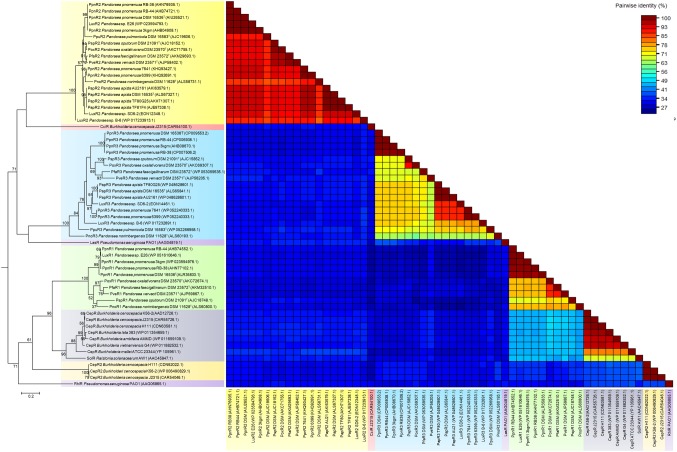
LuxR phylogenetic tree and pairwise identity matrix analyses of Pandoraea species and closely related species. Canonical LuxR1 clustered closely with CepR and SolR. LuxR2 and LuxR3 solos formed a distinct cluster with CciR and LasR as the outgroup, respectively, representing evolutionary distinct branches of LuxR. Bootstrap values (expressed as percentages of 1,000 replications) greater than 50%. Bar, 0.2 substitutions per amino acid position.